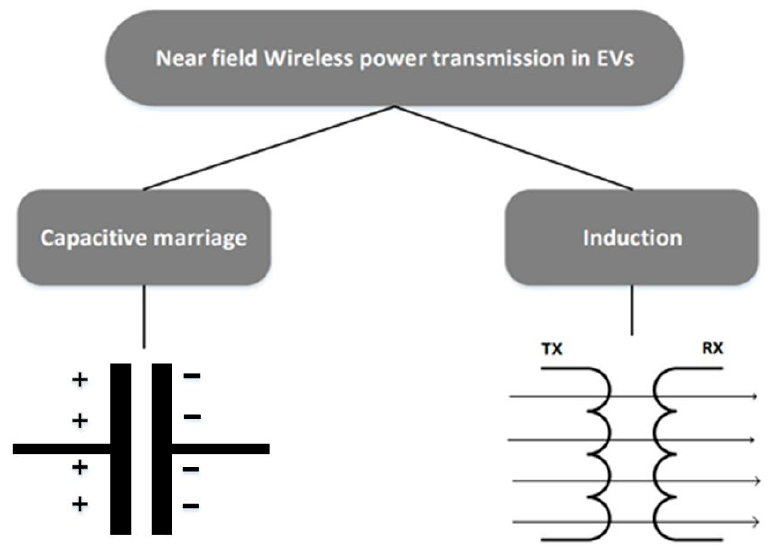
Figure 11. Types of wireless power transmission.